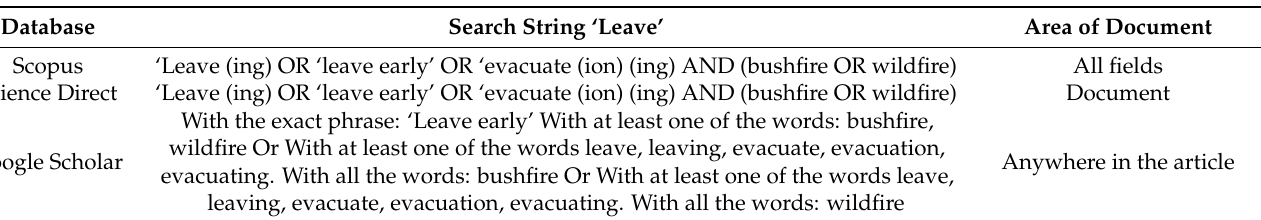
Table 1. Search string for